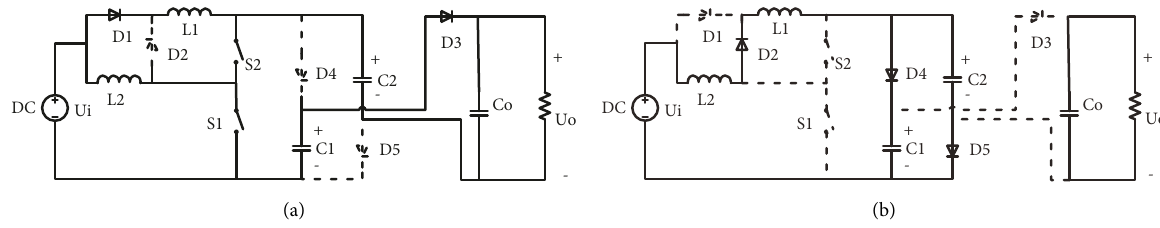
Figure 4: Operating principles of the DS-HS converter in CCM. (a) When S